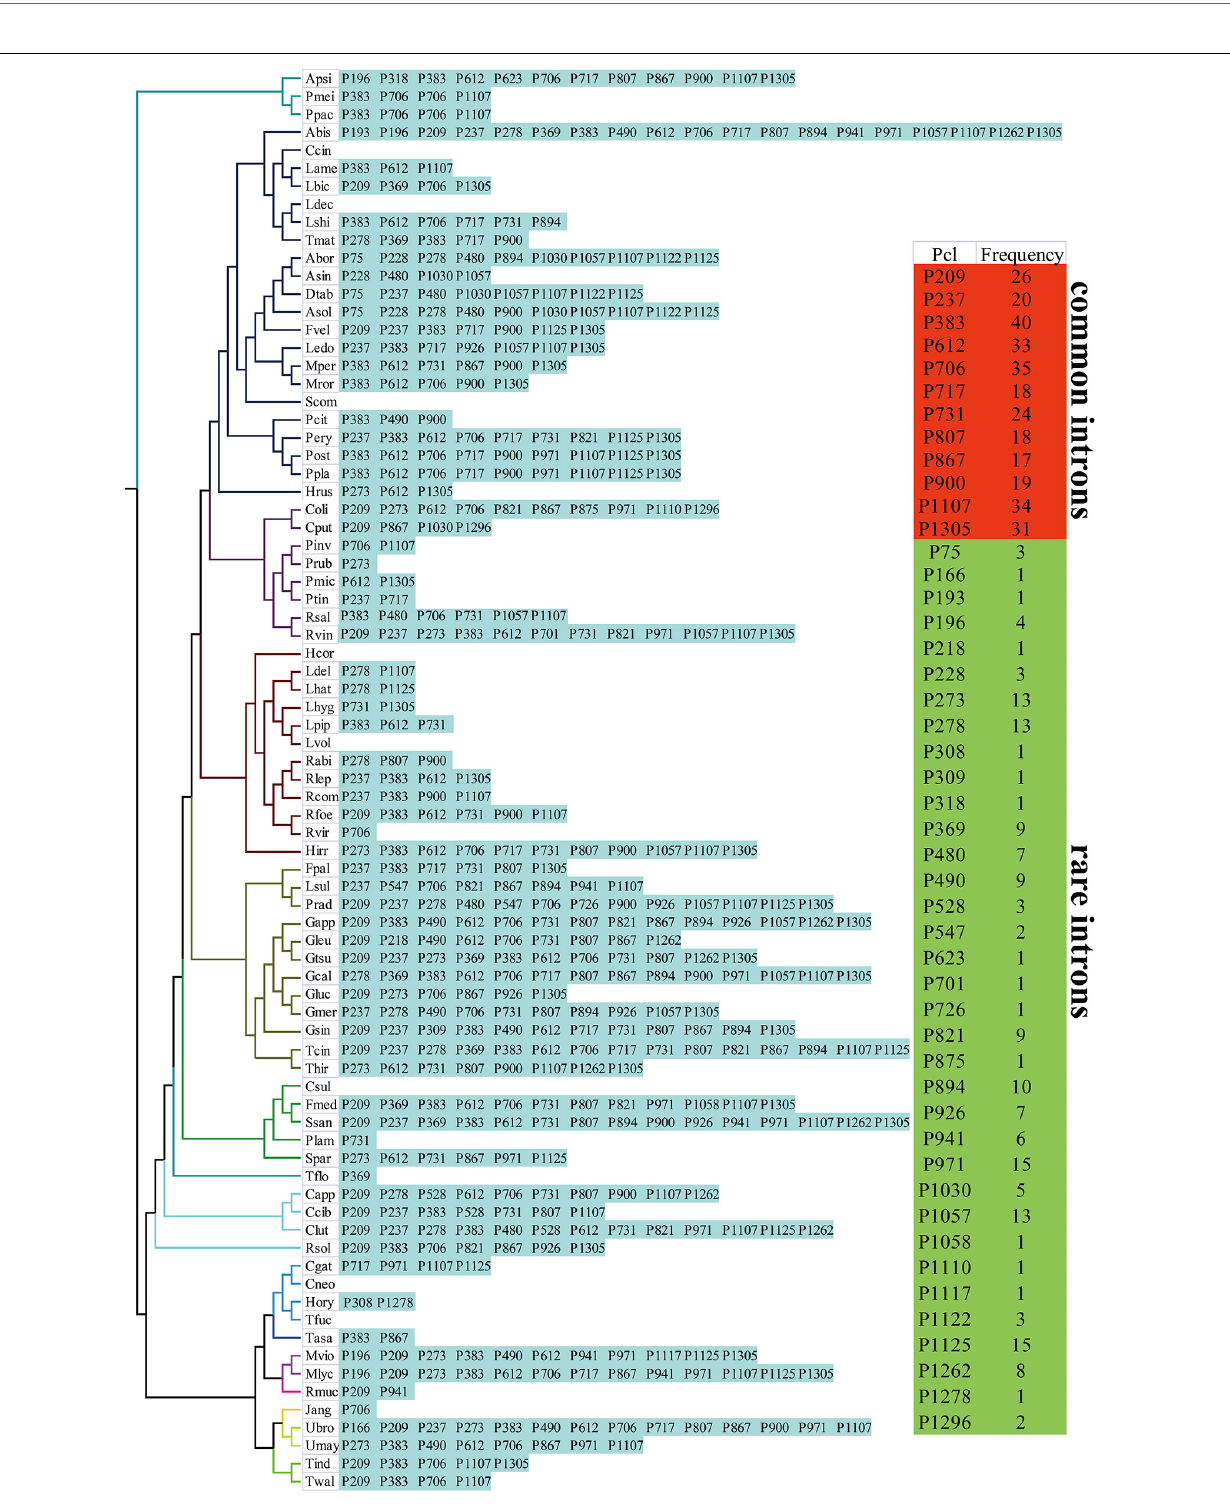
Frontiers in Microbiology |